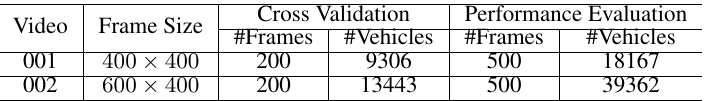
Table 1. Information on the evaluation datasets